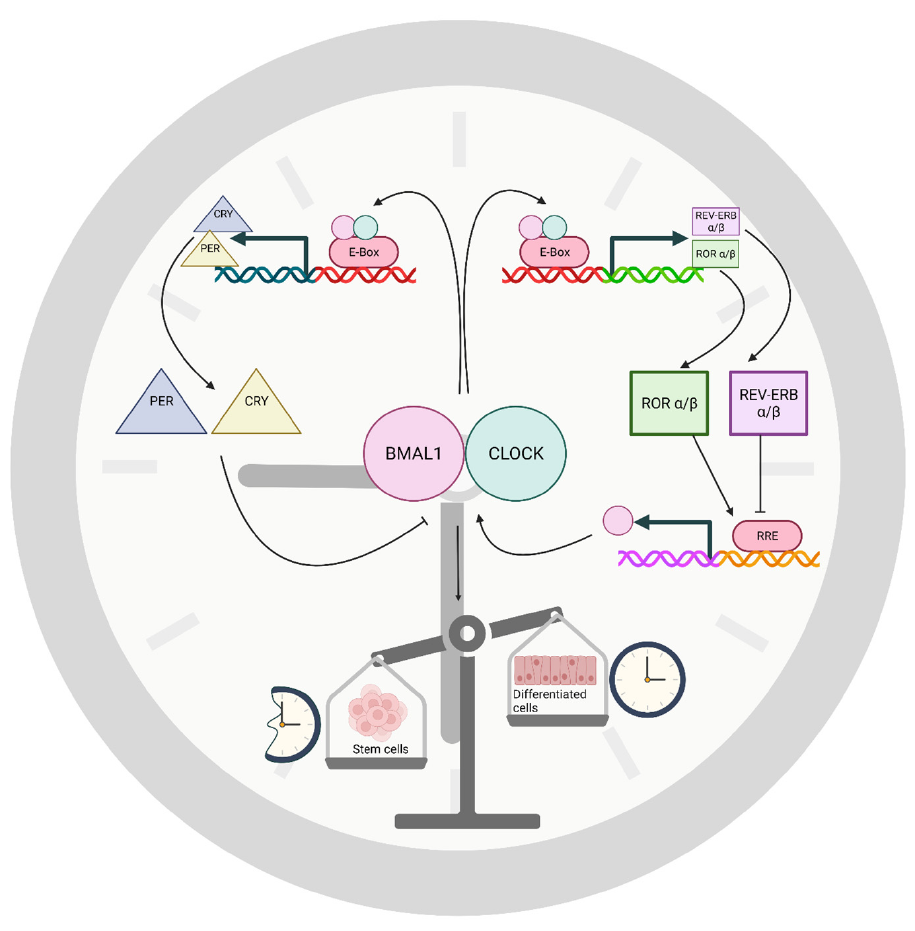
Figure 1. The basic circadian clock timing mechanism of mammals. Two feedback loops work together to provide approximately 24-h rhythms in interacting transcription, translation, and gene regulation. The oscillations simultaneously modulate clock-controlled genes that generate rhythms outside this core timing mechanism. A dimer of transcription factors BMAL1 and CLOCK activates genes through the E-box and related promoter elements. Members of the Per and Cry gene families are, thereby, induced by BMAL1-CLOCK. Resulting PER and CRY proteins enter the nucleus and, through a larger complex, inhibit BMAL1-CLOCK activity, suppressing their own genes but only after a sufficient delay to produce the period of the circadian rhythm. A second loop consists of Rev-erb and ROR genes that are induced by BMAL1-CLOCK, ultimately inducing the Bmal1 gene through a competitive interaction of transcription factors at the RORE of the Bmal1 gene. A generalized view of circadian timing during cell differentiation suggests that circadian timing is suppressed in stem cells, indicated by the broken clock, followed by emergence of a functional clock in progenitor cells and during cell maturation.